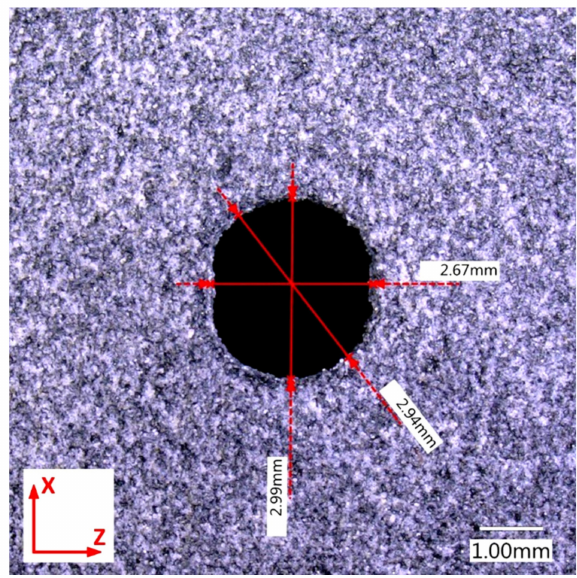
Figure 15. Measured hole diameter of part